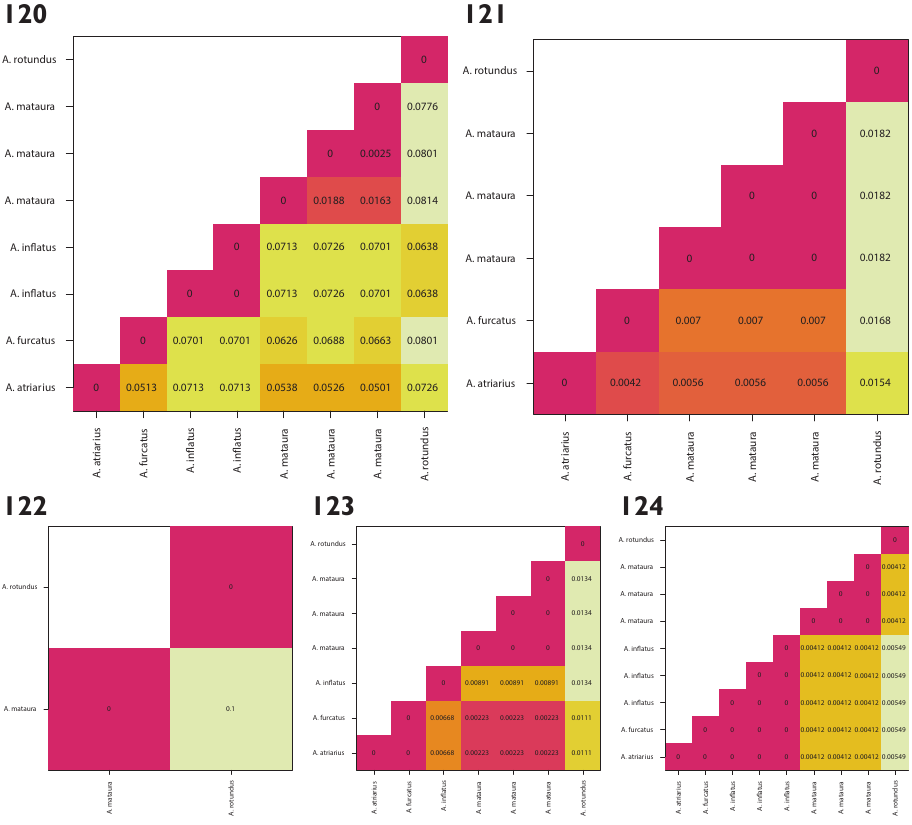
Figures 120–124. Heatmaps of the uncorrected pairwise genetic distances between Austromonticola specimens sampled. Lighter colours indicate greater distances. 120 the 3 ' region of the COI mitochon- drial protein-coding gene 121 CAD nuclear protein-coding gene 122 the 5 ' (“barcoding”) region of COI 123 ArgK nuclear protein-coding gene 124 28S nuclear ribosomal RNA